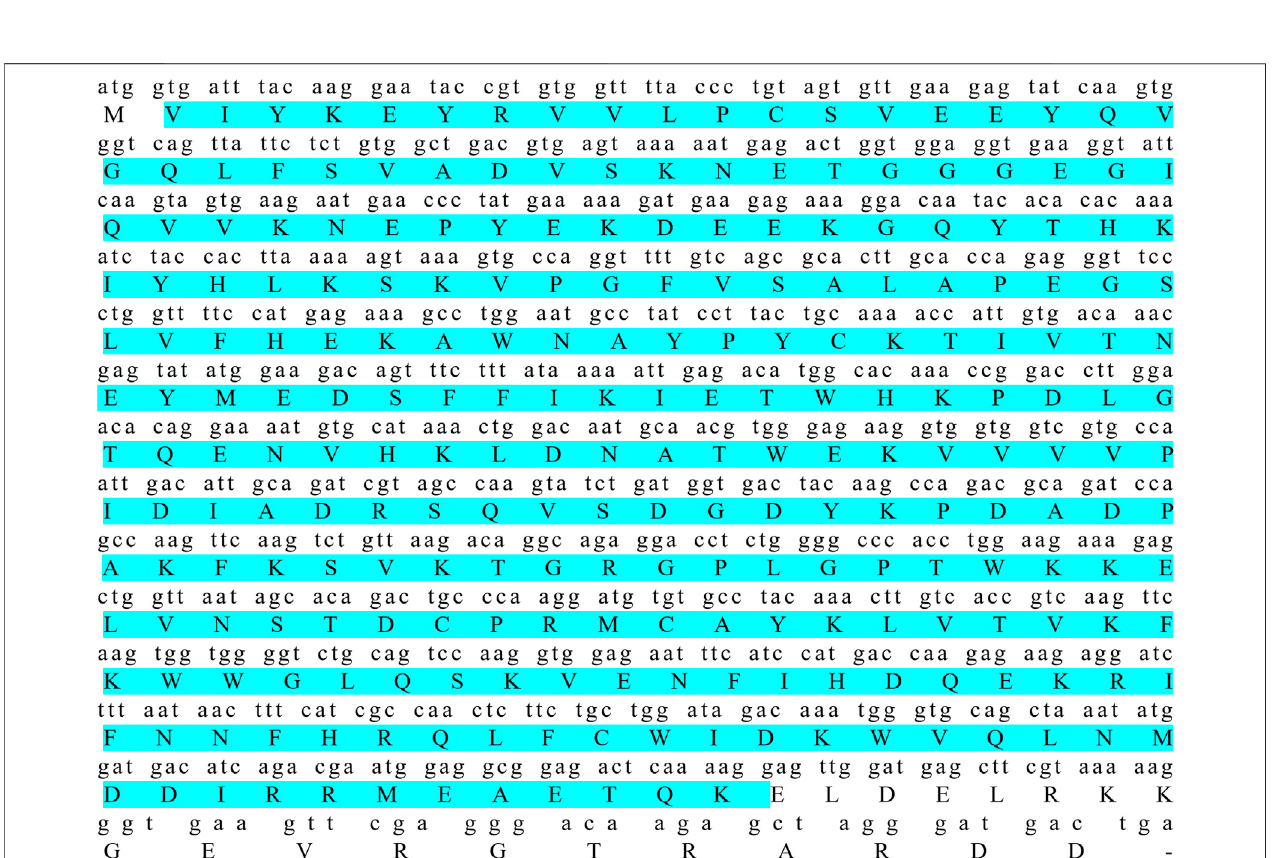
FIGURE 1 | Coding sequence and deduced amino acid sequence of pitp β _w . Amino acids in sky blue indicate the classic Pitp domain.